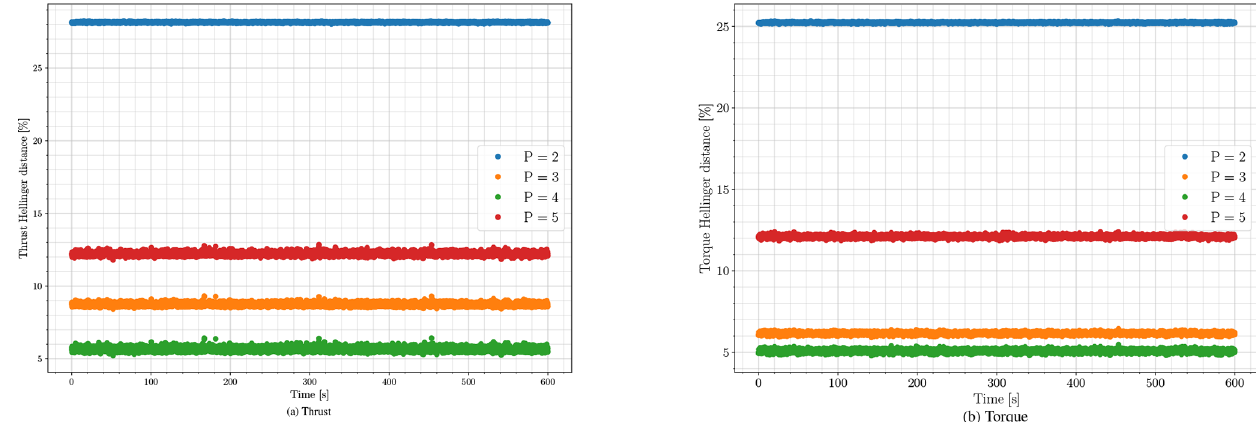
Figure 5. Hellinger distance between the different polynomial order surrogate models for 1 million MCSs of the selected thrust and torque surrogates and the 48000 reference case simulations at every time step.